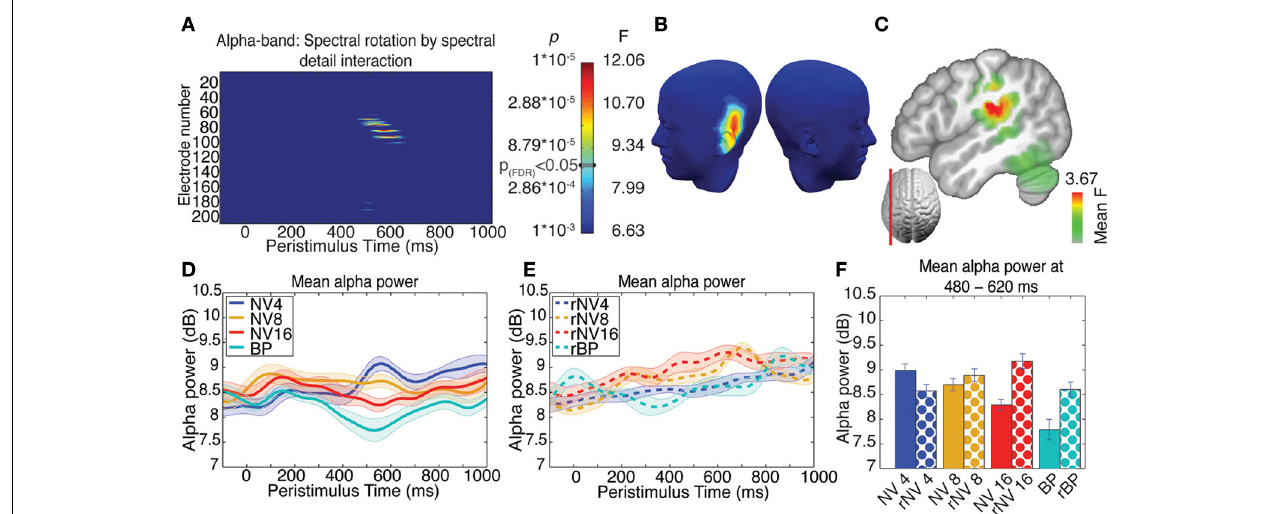
FIGURE 5 | Results of ANOVA of induced activity in the alpha-band. (A) Electrode-by-time plot of the p -values for the interaction of rotation × spectral detail with corresponding F - and p -values, thresholded at p = 0 . 001, revealing the time-window of interest (462–633ms). The color bar indicates the corresponding F - and p -values, the threshold for p (FDR) < 0 . 05 is indicated. (B) Topography of this effect, using the same color scaleasin (A) atthepeakoftheeffect(533ms),indicatingacontributionof left-temporalsources. (C) Localizationofthiseffectintheinversespace,the mainsourcebeingintheleftsupramarginalgyrusextendingintoleftinferior